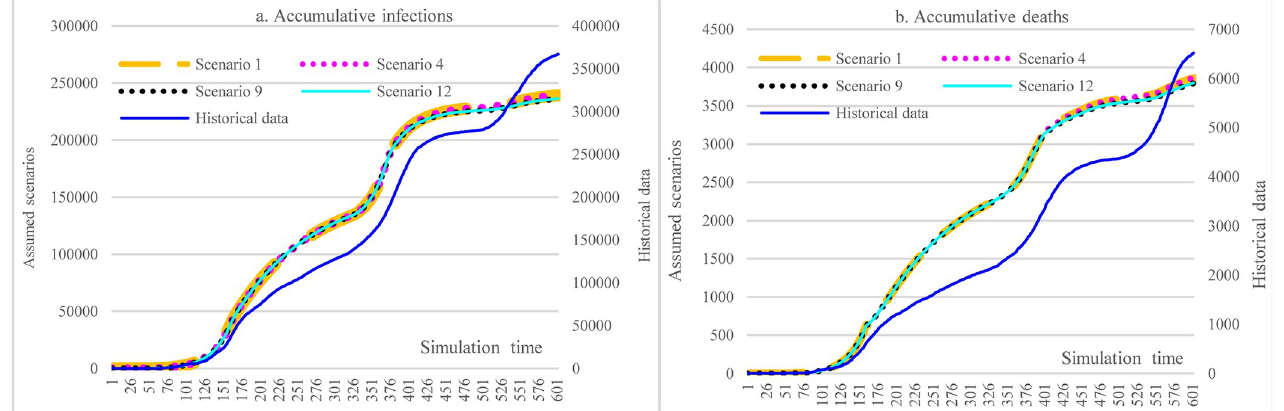
Fig 4. Impacts of hospital capacity, vaccine efficacy, and social distancing in counterfactual analysis.